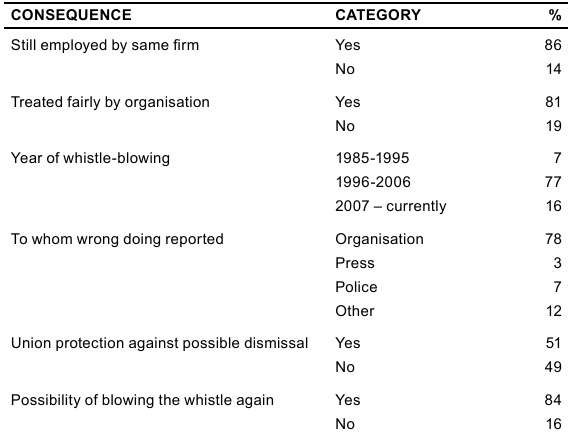
Table 4 Frequency distribution results of consequences of